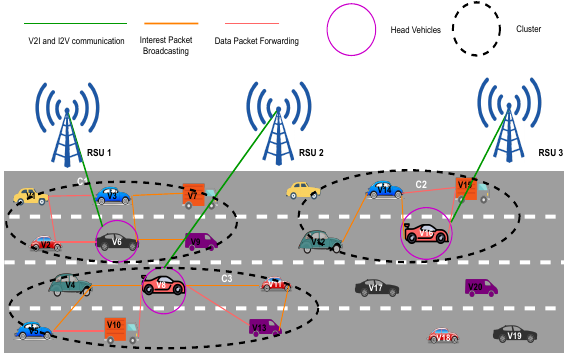
Figure 5. Interest Packet Broadcasting and Data Packet Forwarding in Proposed